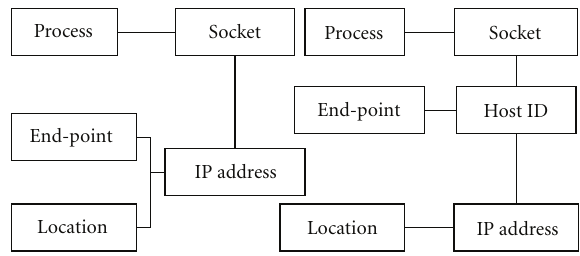
Figure 1: Identity and location roles separation.